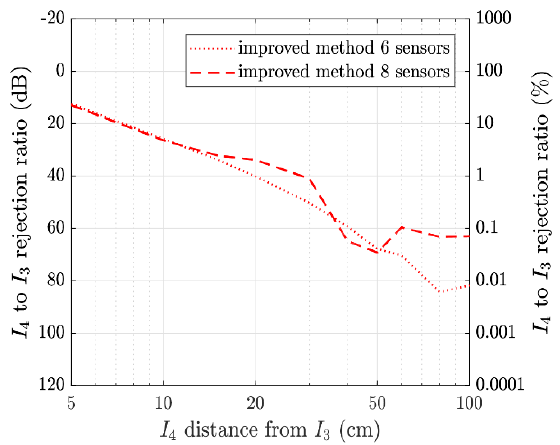
Figure 5. Result of measurement (6 and 8 sensors).